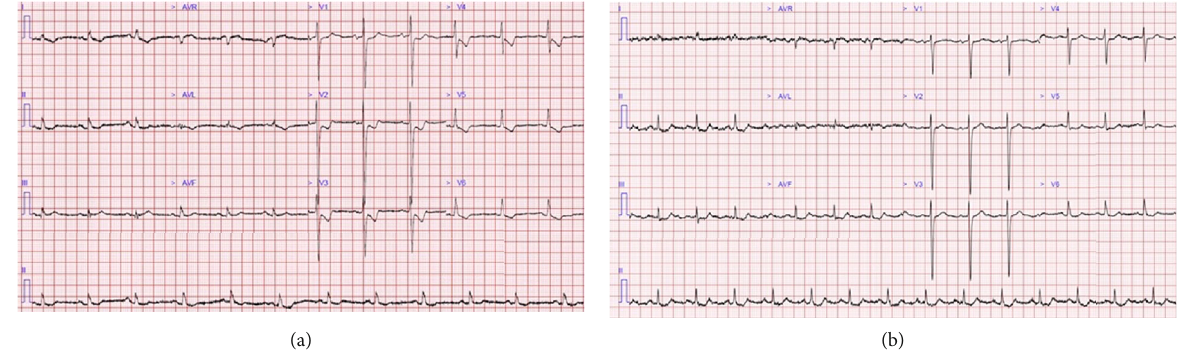
Figure 1: Electrocardiogram demonstrating (a) anterolateral ischaemic changes (ST depression and T wave inversion); (b) older ECG 6 months earlier.